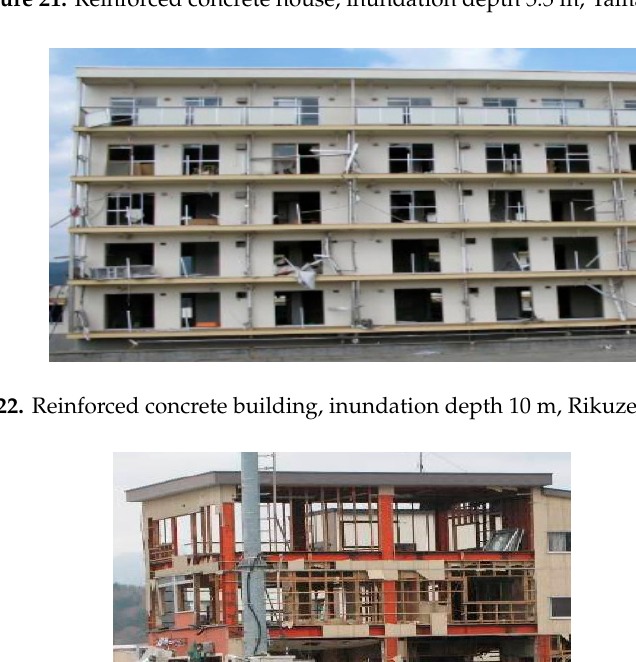
Figure 21. Reinforced concrete house, inundation depth 5.5 m, Yamada-cho.